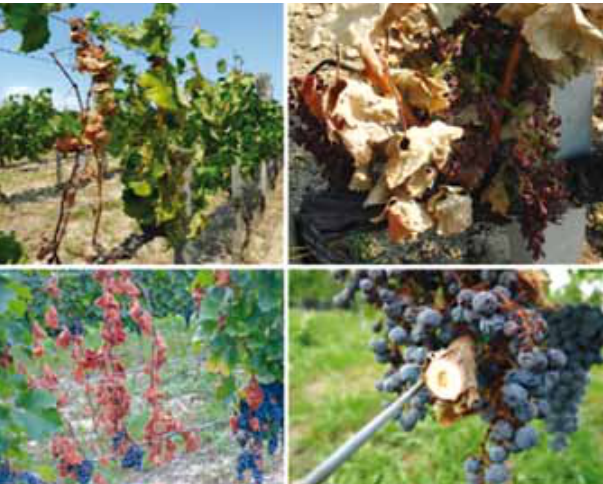
Figure 1: Apoplexy symptoms on Hárslevelű variety in Tokaj Wine Region (top) and on Merlot variety in Szekszárd Wine Region (under) Photo: Kovács and Sándor,